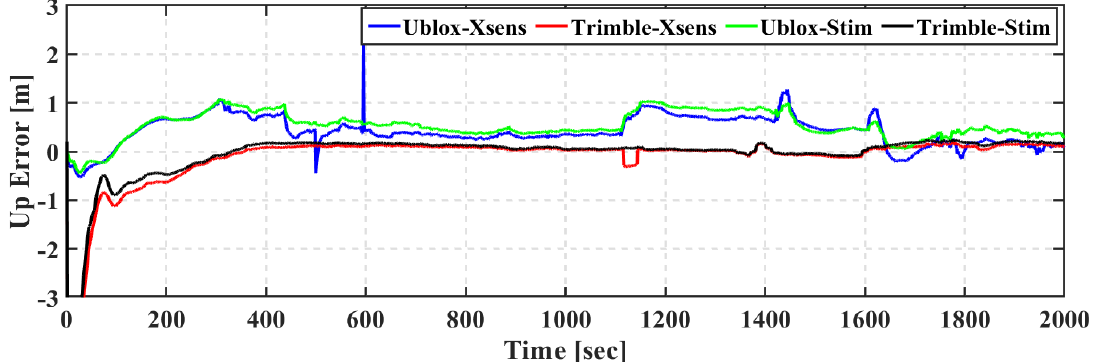
Figure 21. Third field trial: East positioning error of real-time TC GNSS PPP/INS for Ublox–Xsens, Trimble–Xsens, Ublox–Stim, and Trimble–Stim solutions.